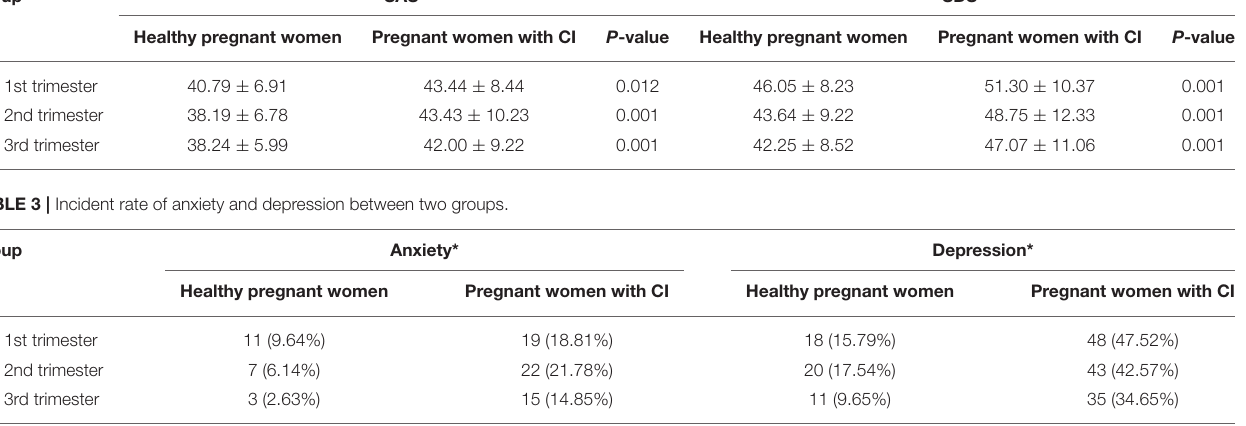
TABLE 2 | Analysis on anxiety and depression during different trimesters. Group